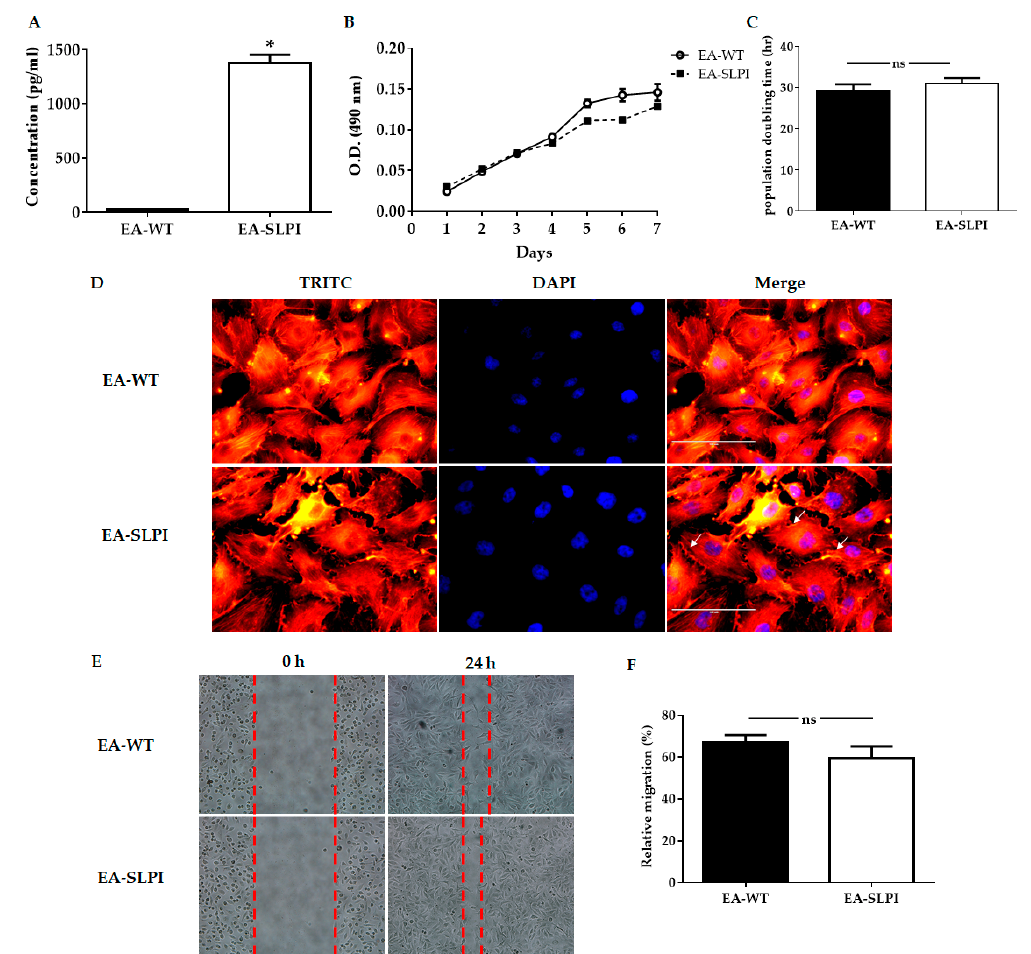
Figure 2. Biological characterization of SLPI-overexpressing EA.hy926 cells. The EA.hy926 cells were transfected with pCMV3-SLPI-GFPSpark tag plasmid by using lipofectamine ® 2000, and the level